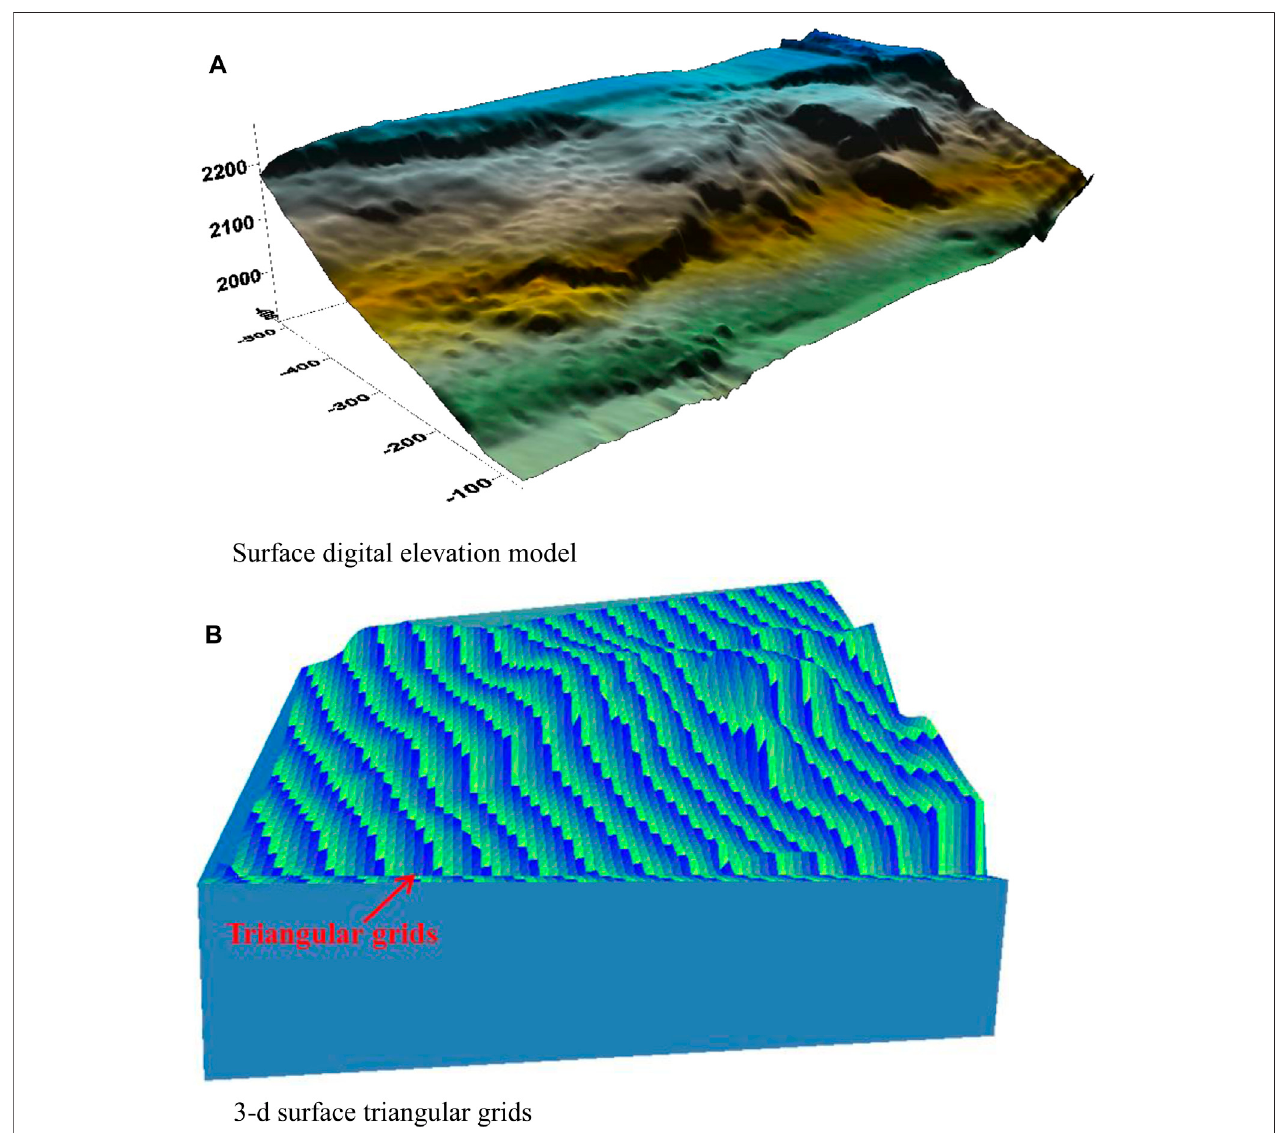
FIGURE 7 | (A) Surface digital elevation model (B) 3D surface triangular grids sliding bed rock block model.